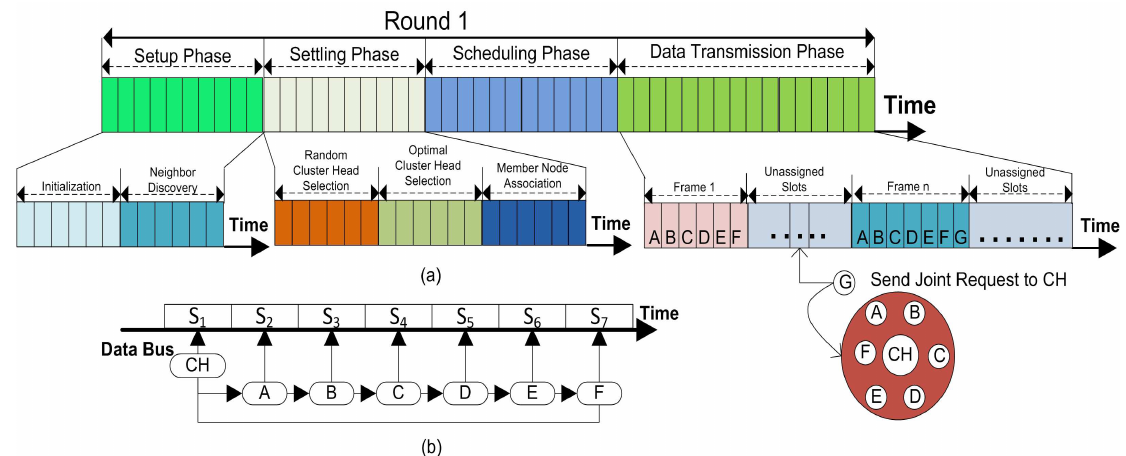
Figure 8. ( a ) The complete description of phases in a round of model-based optimal cluster heads (MOCHs) and the association process of non-cluster member for data forwarding; ( b ) CH data collection during a round in